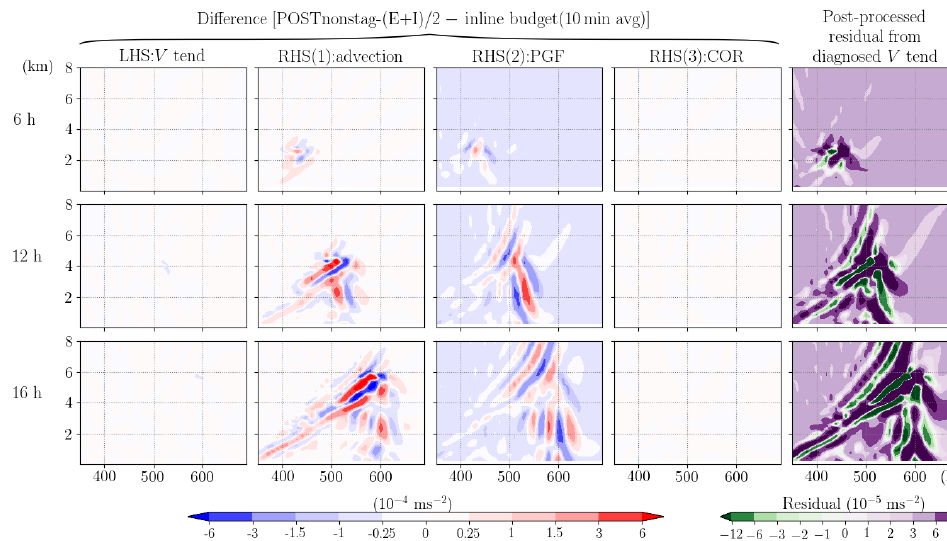
Figure 13. Same as Fig. 11, but the post-processed analysis does not consider C staggering grids (POSTnonstag-(E+I)/2).